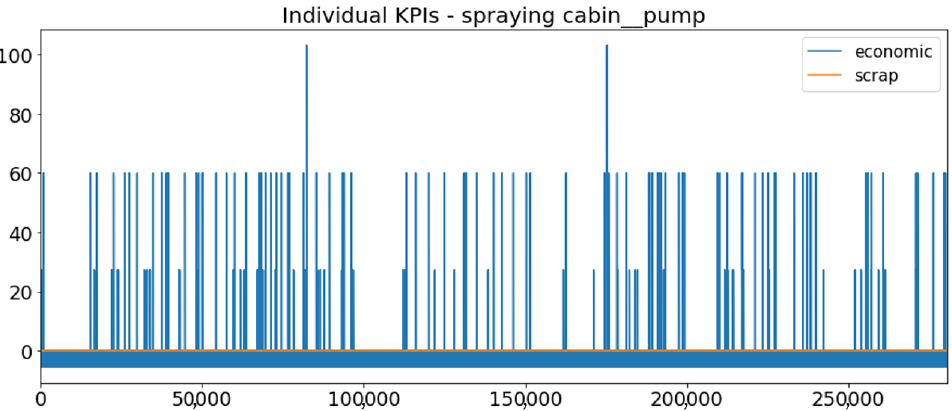
Figure 4. Individual KPI time series for the pump yielded from running the model for the spraying cabin (GORENJE). The simulation interval has a length of 8